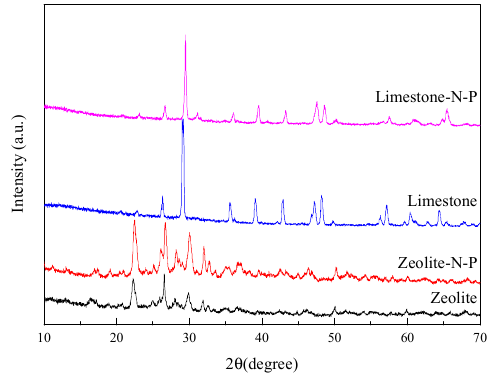
Figure 14. The XRD pattern of zeolite and basalt aggregates, Limestone after adsorption of the test (Limestone-N-P) and Zeolite after simultaneous adsorption of ammonium and phosphate (Zeolite-N-P)